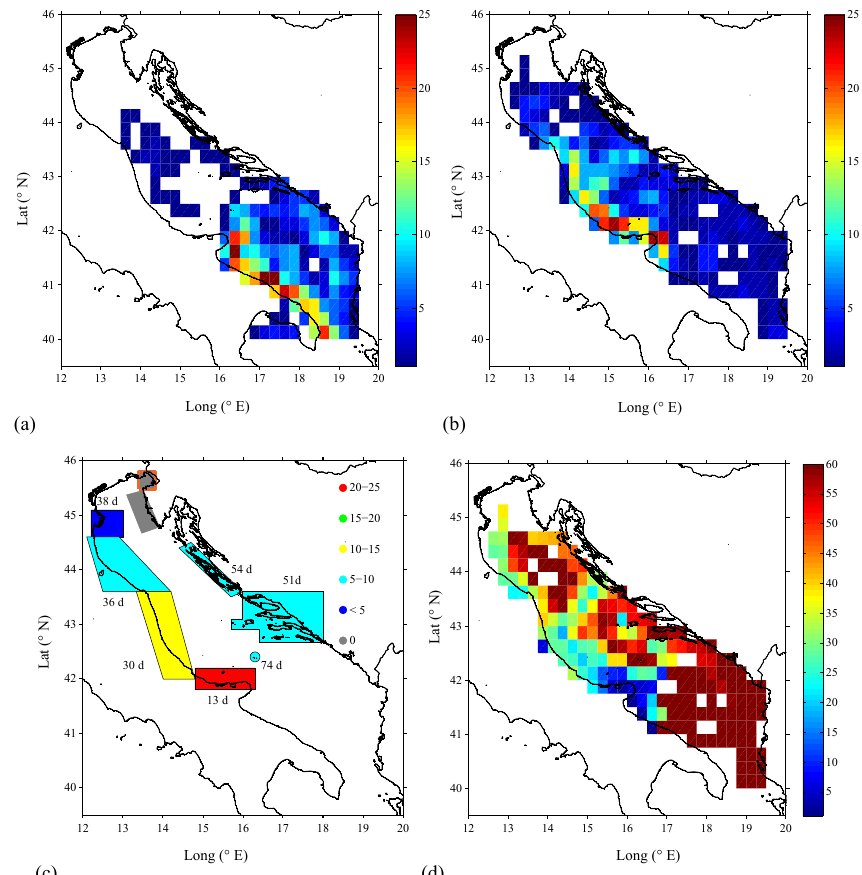
Figure 6. Density of drifter data from (a) trajectories that leave the Gulf of Manfredonia and (b) trajectories that enter the Gulf of Man- fredonia. Densities refer to the number of non-consecutive entries into each 0.25 ◦ bin. (c) The connection percentages (i.e., percentage of drifters that passed through a given SA and reached the Gulf of Manfredonia) and the average time to reach the gulf from each SA computed using the complete drifter data set (see Table 1). Results obtained with less than 10 drifters per SA, as for the Gulf of Trieste, are disregarded and identified by the orange contour around the SA. (d) Transit times of drifters coming from the whole Adriatic Sea entering the Gulf of